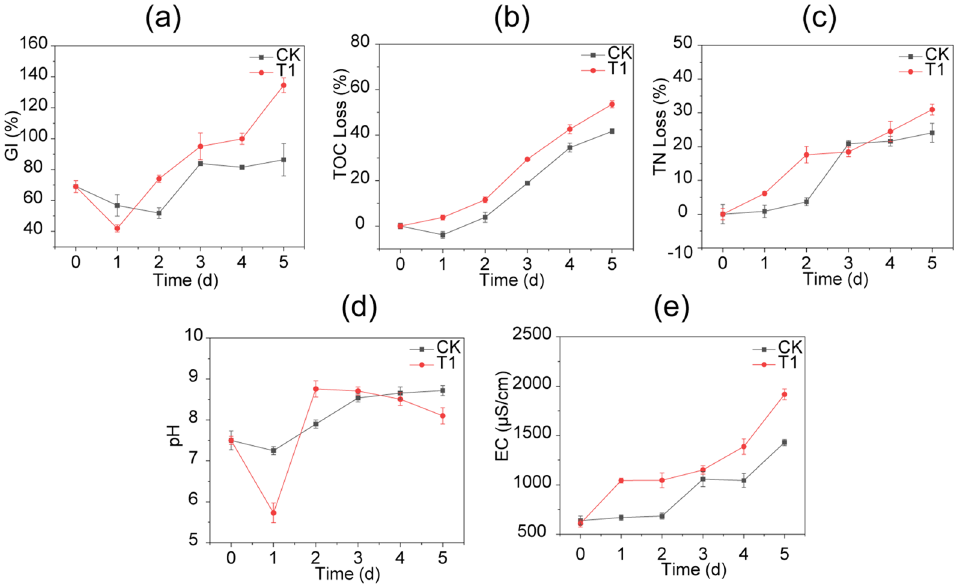
Figure 3. Profiles of GI (a) , TOC (b) , TN (c) , pH (d) and EC (e) during the fermentation process of CK and T1. The data represent the means ± standard deviations from three